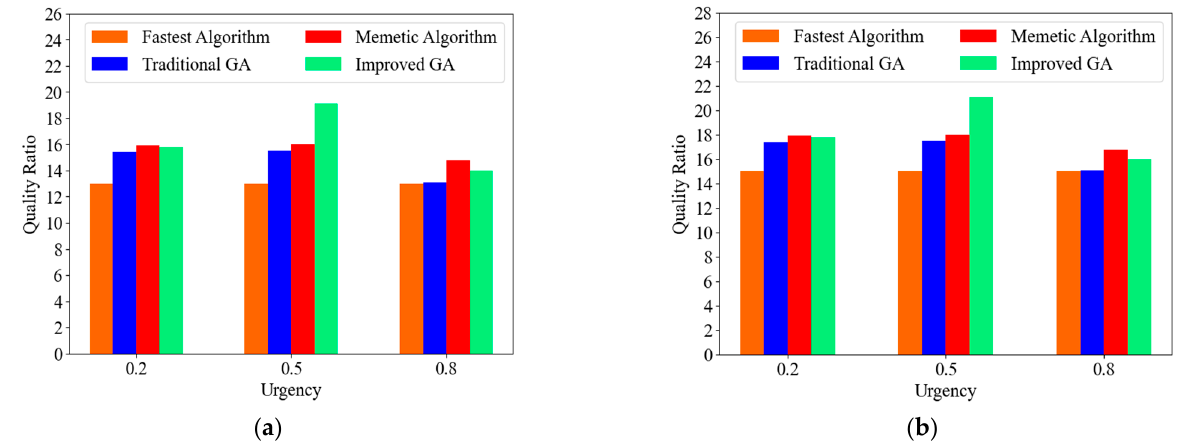
Figure 11. Comparison of path quality ratio under different urgencies. ( a ) Xi’an; ( b ) Wuhan.